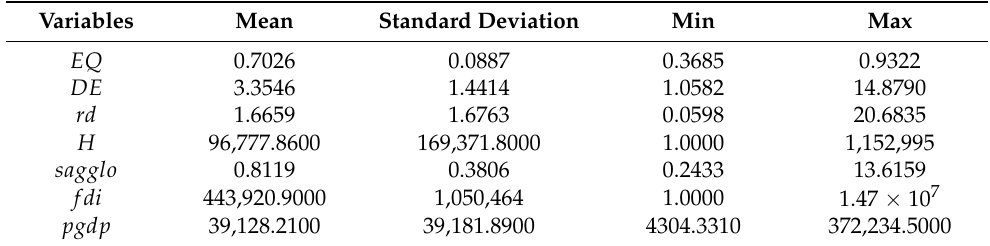
Table 3. Statistical description of